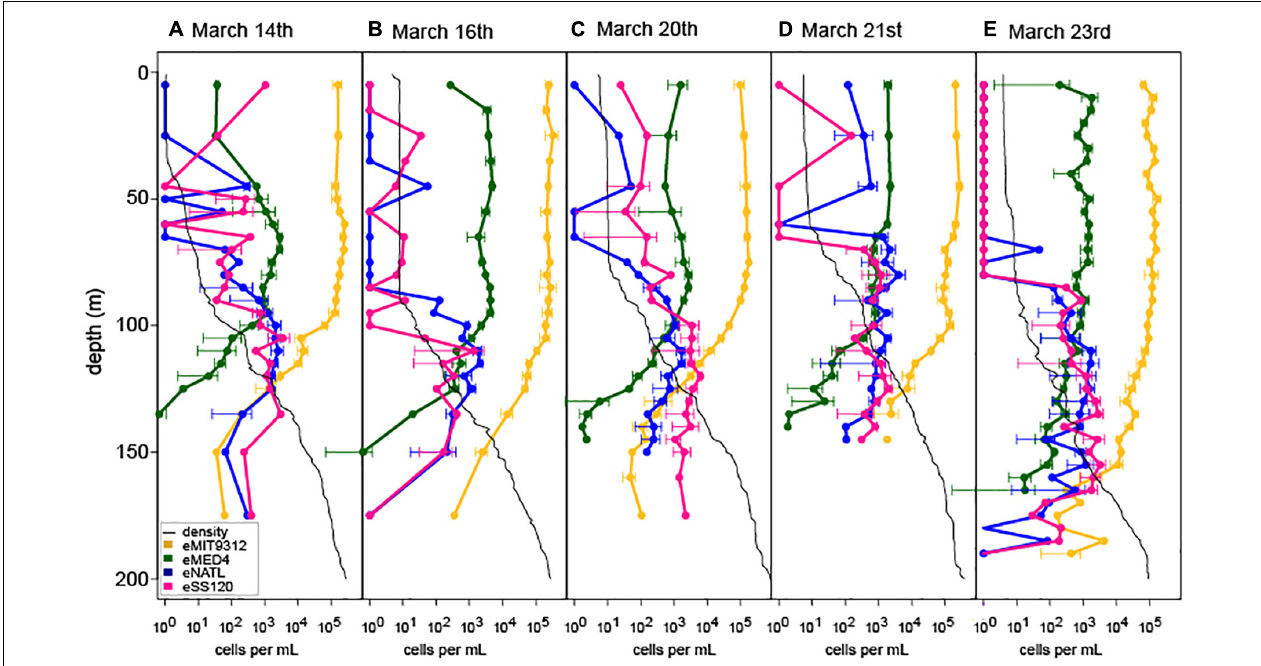
FIGURE 2 | Ecotype abundance of Prochlorococcus over depth profiles across a 2-week period at Station ALOHA (A–E) . Oceanographic context and Prochlorococcus abundance for profiles is marked in Figure 1B . Peak wind speeds and deepest mixing occurred on March 16th (B) and eased through the remaining time course. Density profiles for each cast are show by the black trace in each